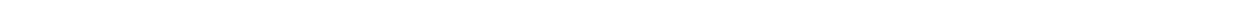
Fig. 5 Biological functions of 1D and 3D ELP nanostructures. a Retention ef fi ciencies of P4 – P10 and the non-polymerized peptide control were measured at 0.5, 4, 12, and 24 h post peptide monomer addition. The retention ef fi ciency was de fi ned as the percentage of cell trapped peptides to the total feeding peptides. b Cytotoxicity of P4 – P10 and the non-polymerized peptide control. Peptide monomers were fed at a concentration of 600 μΜ . c Fluorescence imaging of FITC-C , FITC-P8 , and FITC-P7 in HeLa cells at 0.5, 4, 12, and 24 h post treatment. FITC-C , FITC-P8 , and FITC-P7 , green; cell membrane, red; nucleus, blue. Scale bar, 30 μ m. d Longitudinal fl uorescence imaging of Cy 5-labeled peptide C, 7, and 8 treated mice that bearing HeLa tumor xenograft. All peptides were i.v. injected at a dose of 5.0 mg kg − 1 . The whole-body fl uorescence images were monitored longitudinally using a Maestro fl uorescence imager. e The fl uorescence images of cell actin fi laments (stained with Rhodamine Phalloidin) after treatment with peptide control, peptide 9 and 10 for 12 h. White and yellow arrows represented intact and disrupted actin fi laments, respectively. Actin fi lament, red; nucleus, blue. Scale bar, 10 μ m. f Bio-TEM images of ultrathin sections of HeLa cells and tumor tissues at 12 h post administration of peptide C and 9. Fe-chelated P 18 was labeled on all peptides to enhance the imaging contrast. Red dotted circles represented the ELP gel nanostructure. Scale bar, 5 μ M. g Apoptosis was analyzed in peptide C and peptide 9 treated HeLa cells by FACS. h , Representative images of HeLa xenograft tumors collected from the mice after treatment with saline, peptide c, peptide 9, and peptide 10 at day 14. Ruler unit, cm. i The HeLa tumor growth curves after i.v. injection of saline, peptide c, peptide 9, and peptide 10 at a dose of 5 mg kg − 1 . Error bars indicated s.d. ( n = 3). The statistical signi fi cance (* p < 0.05 and *** p < 0.001) between all pairs of components was assessed using one-way analysis of variance (ANOVA) followed by post hoc Tukey ’ s test. j The body weight variation of HeLa tumor-bearing mice during treatment. Error bars indicated s.d. ( n =